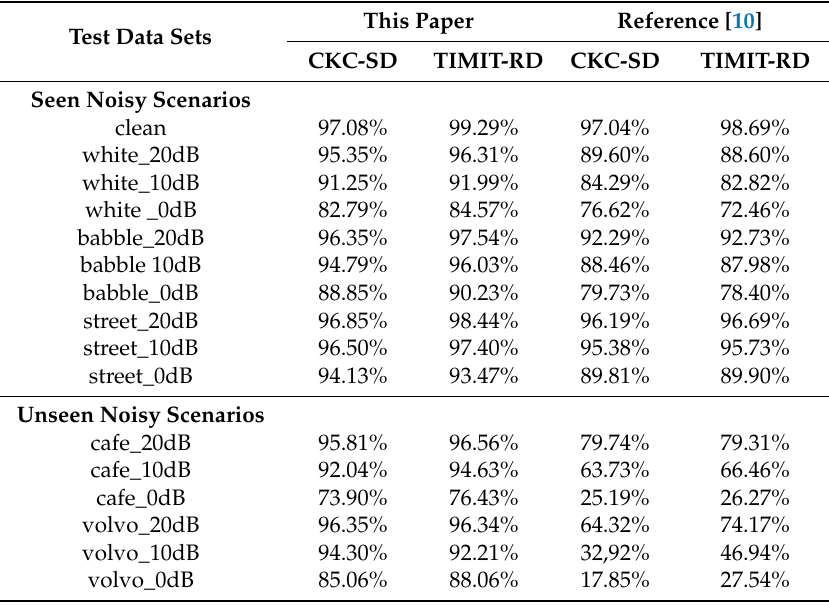
Table 6. Comparison of accuracy of different algorithms Test Data